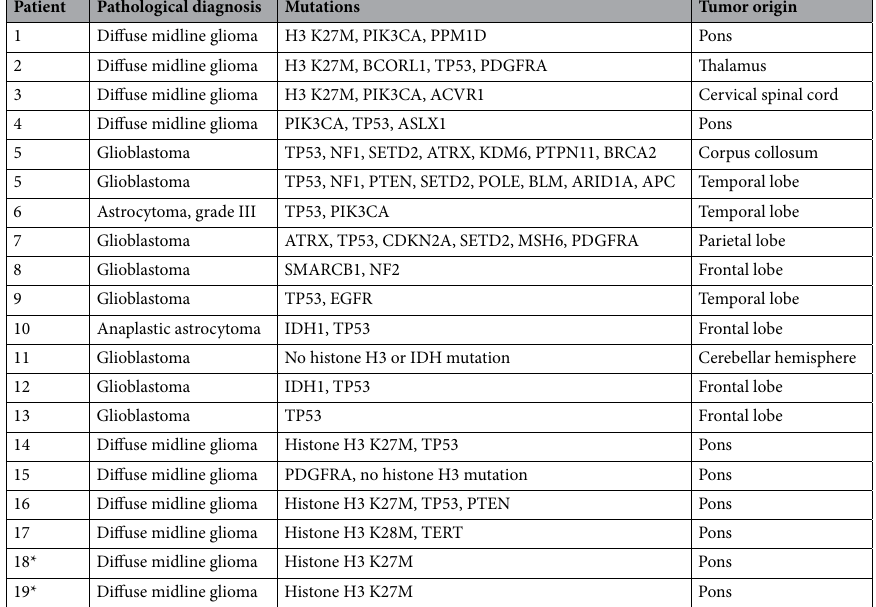
Table 2. Mutations identified in individual pediatric brain tumors. Patients 1–8 underwent 500 gene panel mutation analysis. Patients 9–16 underwent either 50 gene panel mutation analysis. Patient 17 underwent Foundation One analysis. Patients 18 and 19 underwent standard pathologic analysis with immunohistochemistry stains for histone H3 K27M mutation. 50 gene panel analysis includes PIK3CA but not ACVR1 mutation